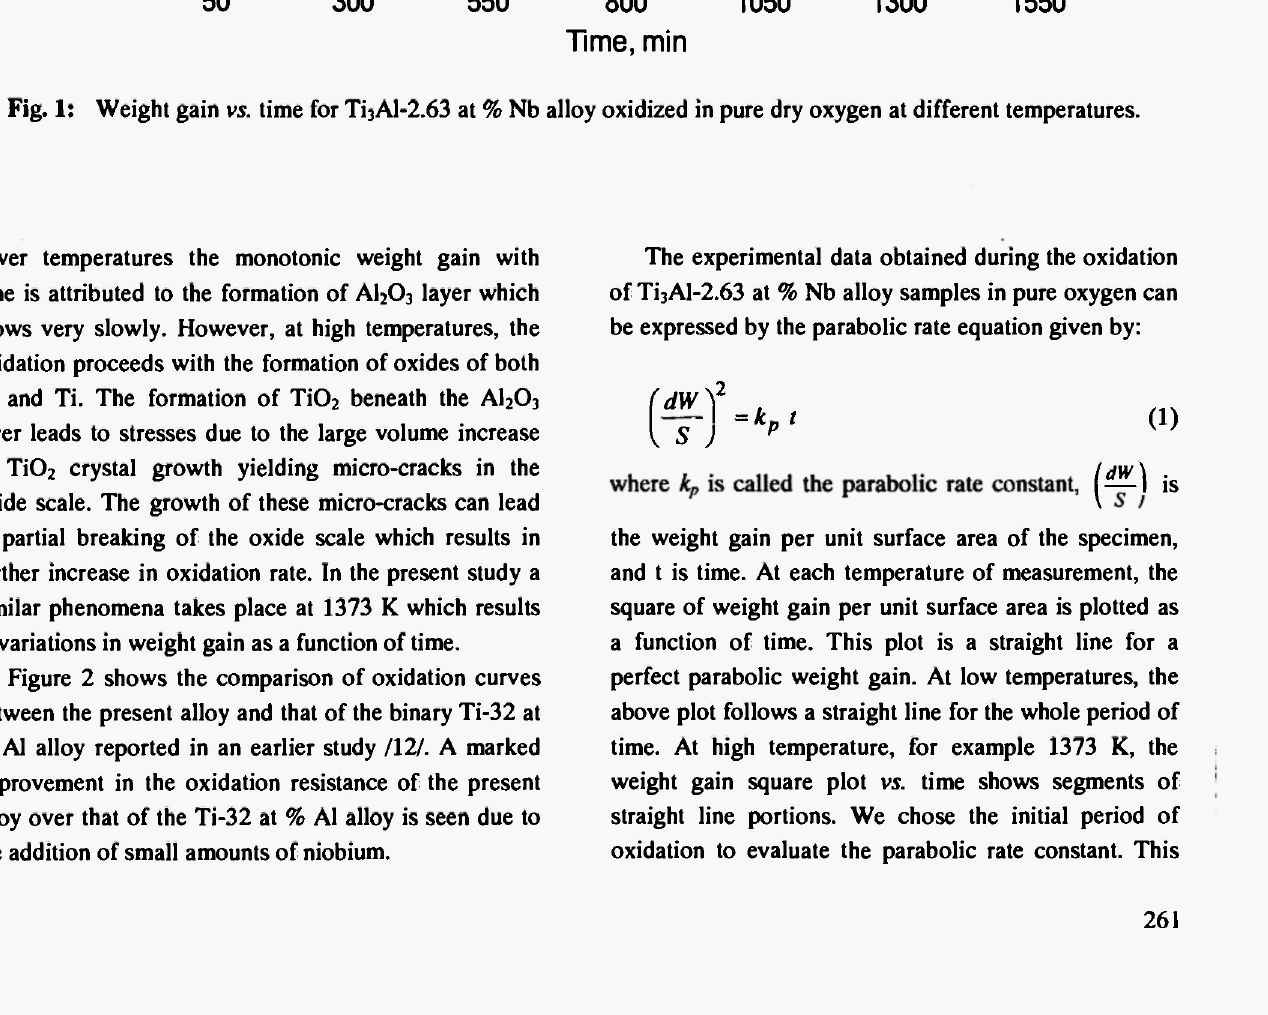
Fig. 1: Weight gain vs. time for Ti 3 Al-2.63 at % Nb alloy oxidized in pure dry oxygen at different